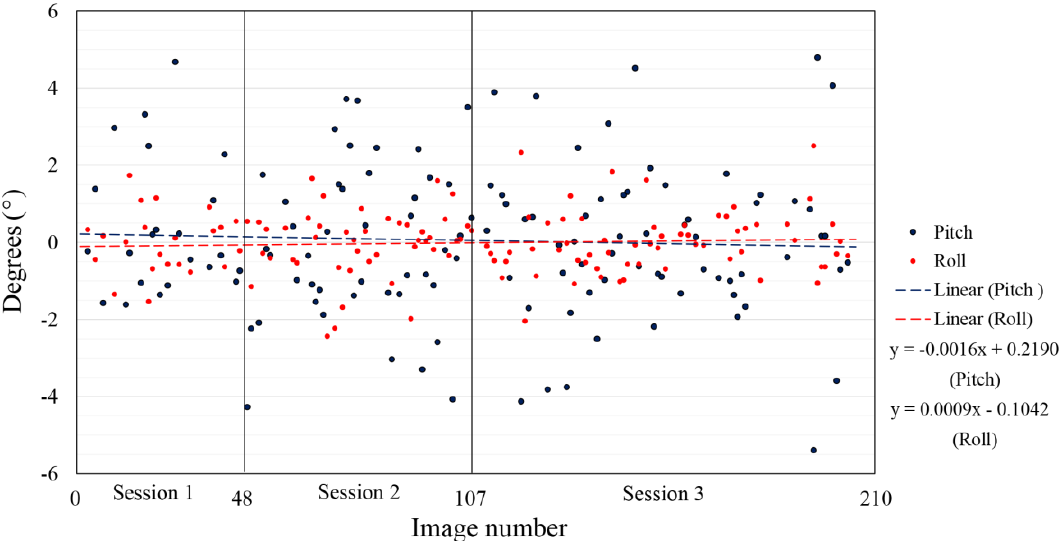
Figure 9. Roll and pitch parameter values and trend line for three sessions of indoor flight.